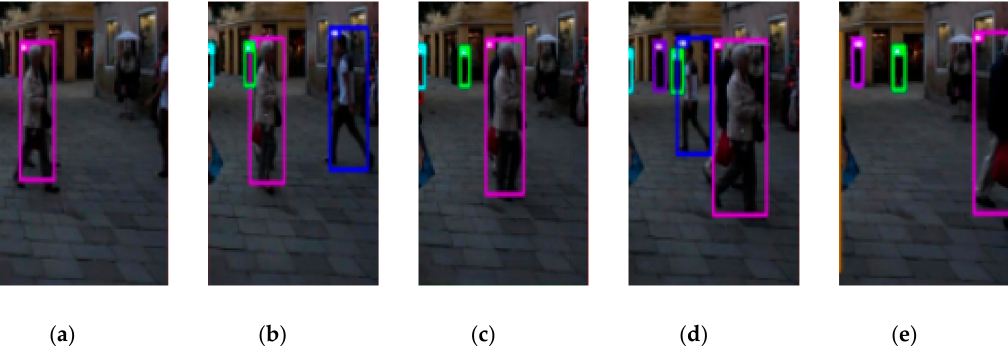
Figure 2. An example of an object state transition. (a–e) are from MOT17-02-SDP in the MOT17 benchmark dataset. Bounding boxes of different colors represent different objects.